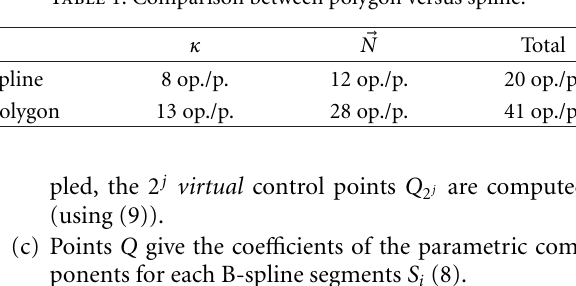
Table 1: Comparison between polygon versus